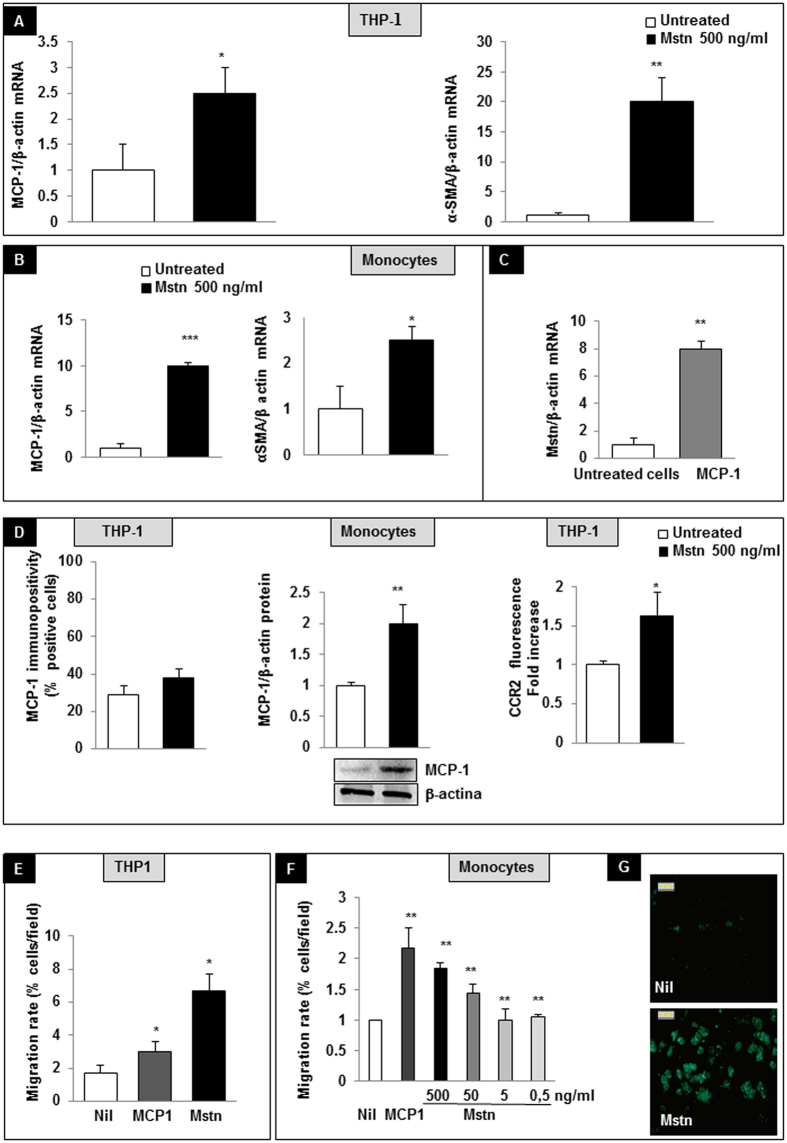
Effects of Myostatin (Mstn) on monocytes.(A) In THP-1 cell line, Mstn induces MCP-1 and α-smooth muscle actin (α-SMA) mRNAs. (B) In human freshly isolated monocytes, Mstn overexpressed MCP-1 and α-SMA mRNAs; (C) MCP-1 increased Mstn mRNA expression; mRNA levels were determined by real time PCR. All data were first normalized to β-actin mRNA and expressed as fold increase ± SEM versus untreated cells (D) MCP-1 and CCR2 protein expression; MCP-1 was evaluated in THP-1 cells by immunocytochemistry and in freshly isolated human monocytes by western blot after a 16 hour and one hour of Mstn treatment respectively. CCR2 membrane expression was evaluated on THP-1 cells after 8 hours of Mstn exposure. (E) Migration assay of THP-1 cells toward control medium, Mstn enriched medium (500 ng/ml), MCP-1 (as positive control). (F) Chemotaxis of freshly isolated monocytes, toward a Mstn-enriched medium at different concentrations. MCP-1 was used as positive control. (G) Mstn exposition caused F-actin polymerization distributed mainly in the cortical region, as demonstrated by AlexaFluor 488-Phalloidin staining (magnification 40x). *p < 0.05, **p < 0.01, ***p < 0.001 vs. untreated cells.